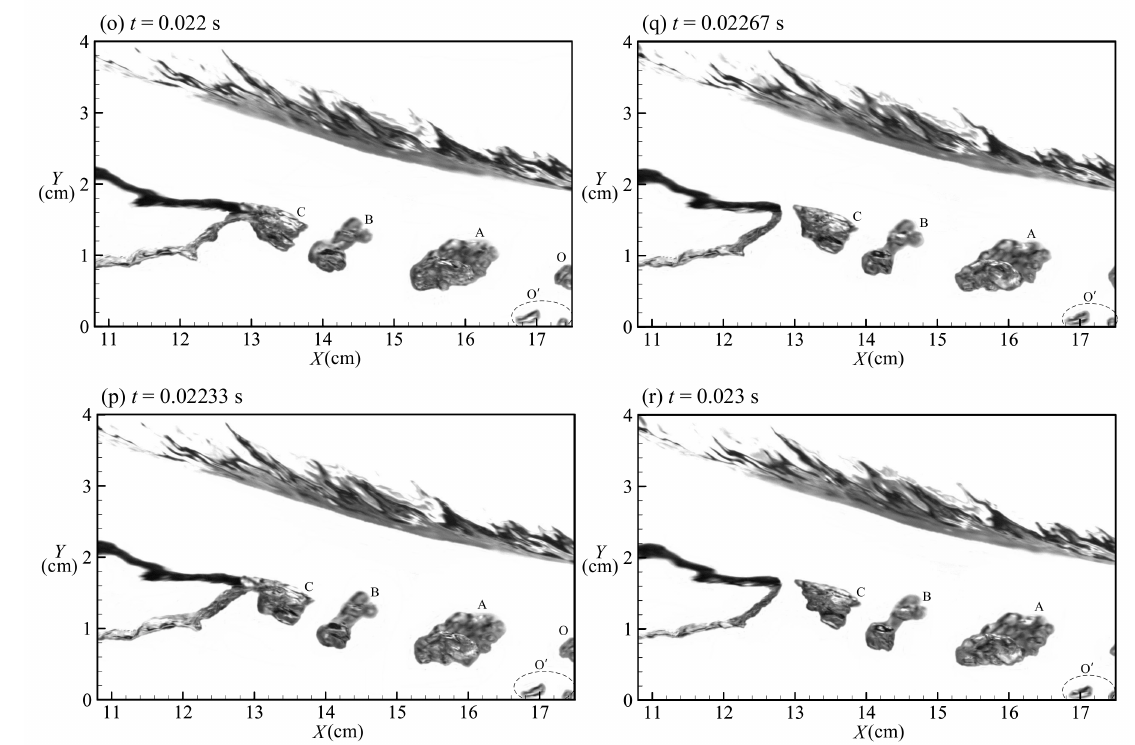
Figure 9. Time series of the instantaneous SIM images after removal of the blurred background, showing that air bubbles are released: ( a – c ) sequentially from a whole wedged tip of air cavity without branching; ( d – h ) simultaneously from different finger-like branches at the wedged tip of air cavity; ( i – r ) via the formation of relatively convergent wedge-shaped tip from which the air bubbles are generated